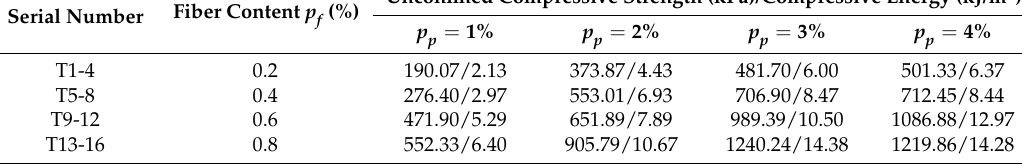
Table 4. Unconfined compressive strength of specimens with 1.5 g/cm 3 dry density and a 48-h curing time.